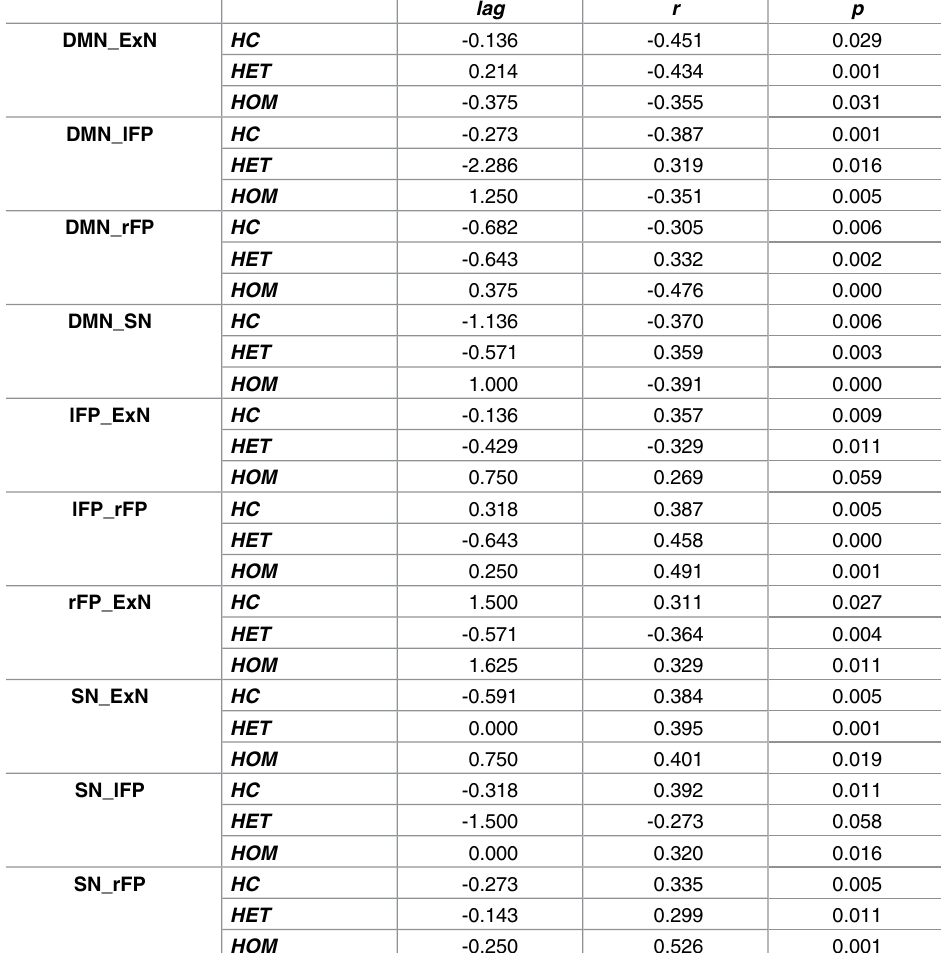
Table 4. Inter-network correlation results. Mean lag, Pearson r index and p values of the inter-network FC correlationsin the group of healthy controls (HC), HET individuals and HOM